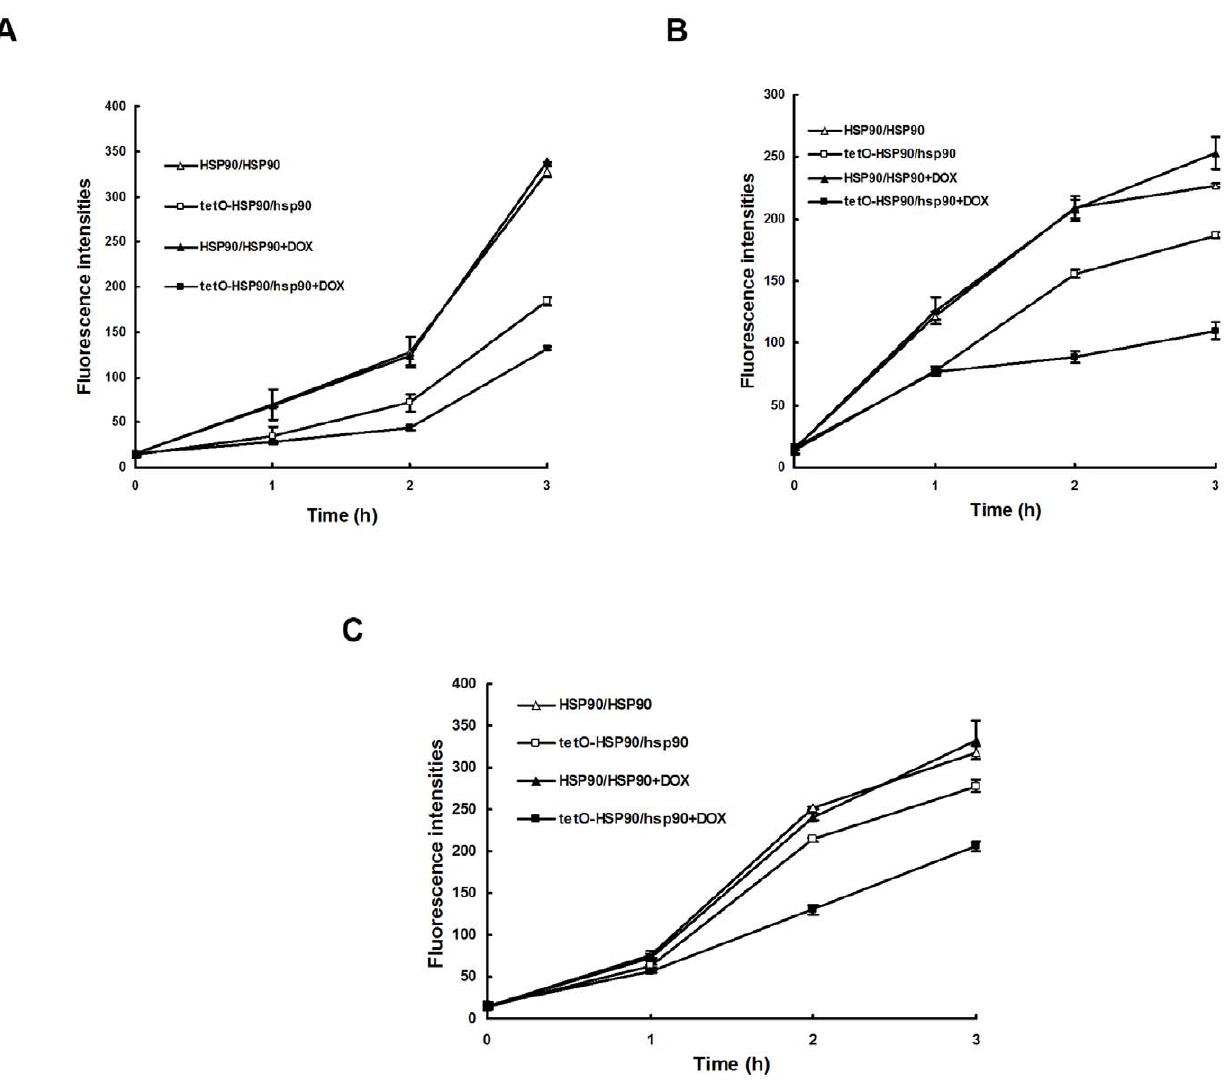
Figure 5. Intracellular ROS production after apoptotic stimuli. Cells were exposed to apoptotic stimuli for 3 h in the absence or presence of 20 m g/ml DOX, and intracellular ROS was detected by DCFH-DA. (A) Quantitative assay of ROS generation after 5 mM H 2 O 2 treatment. (B) Quantitative assay of ROS generation after 60 mM AA treatment. (C) Quantitative assay of ROS generation after 2 m g/ml AMB treatment. Data shown are mean 6 SD from three independent